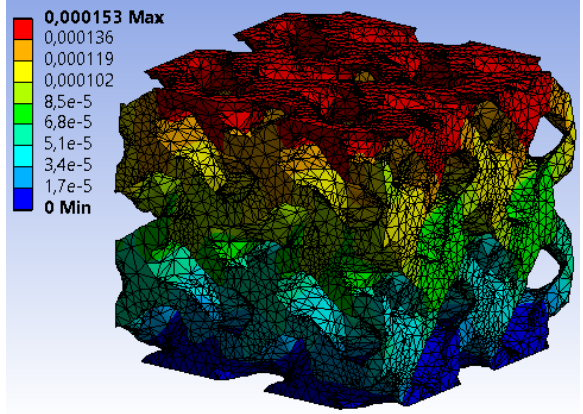
Figure 4. The deformation of the gyroid structure. The unit of deformation is